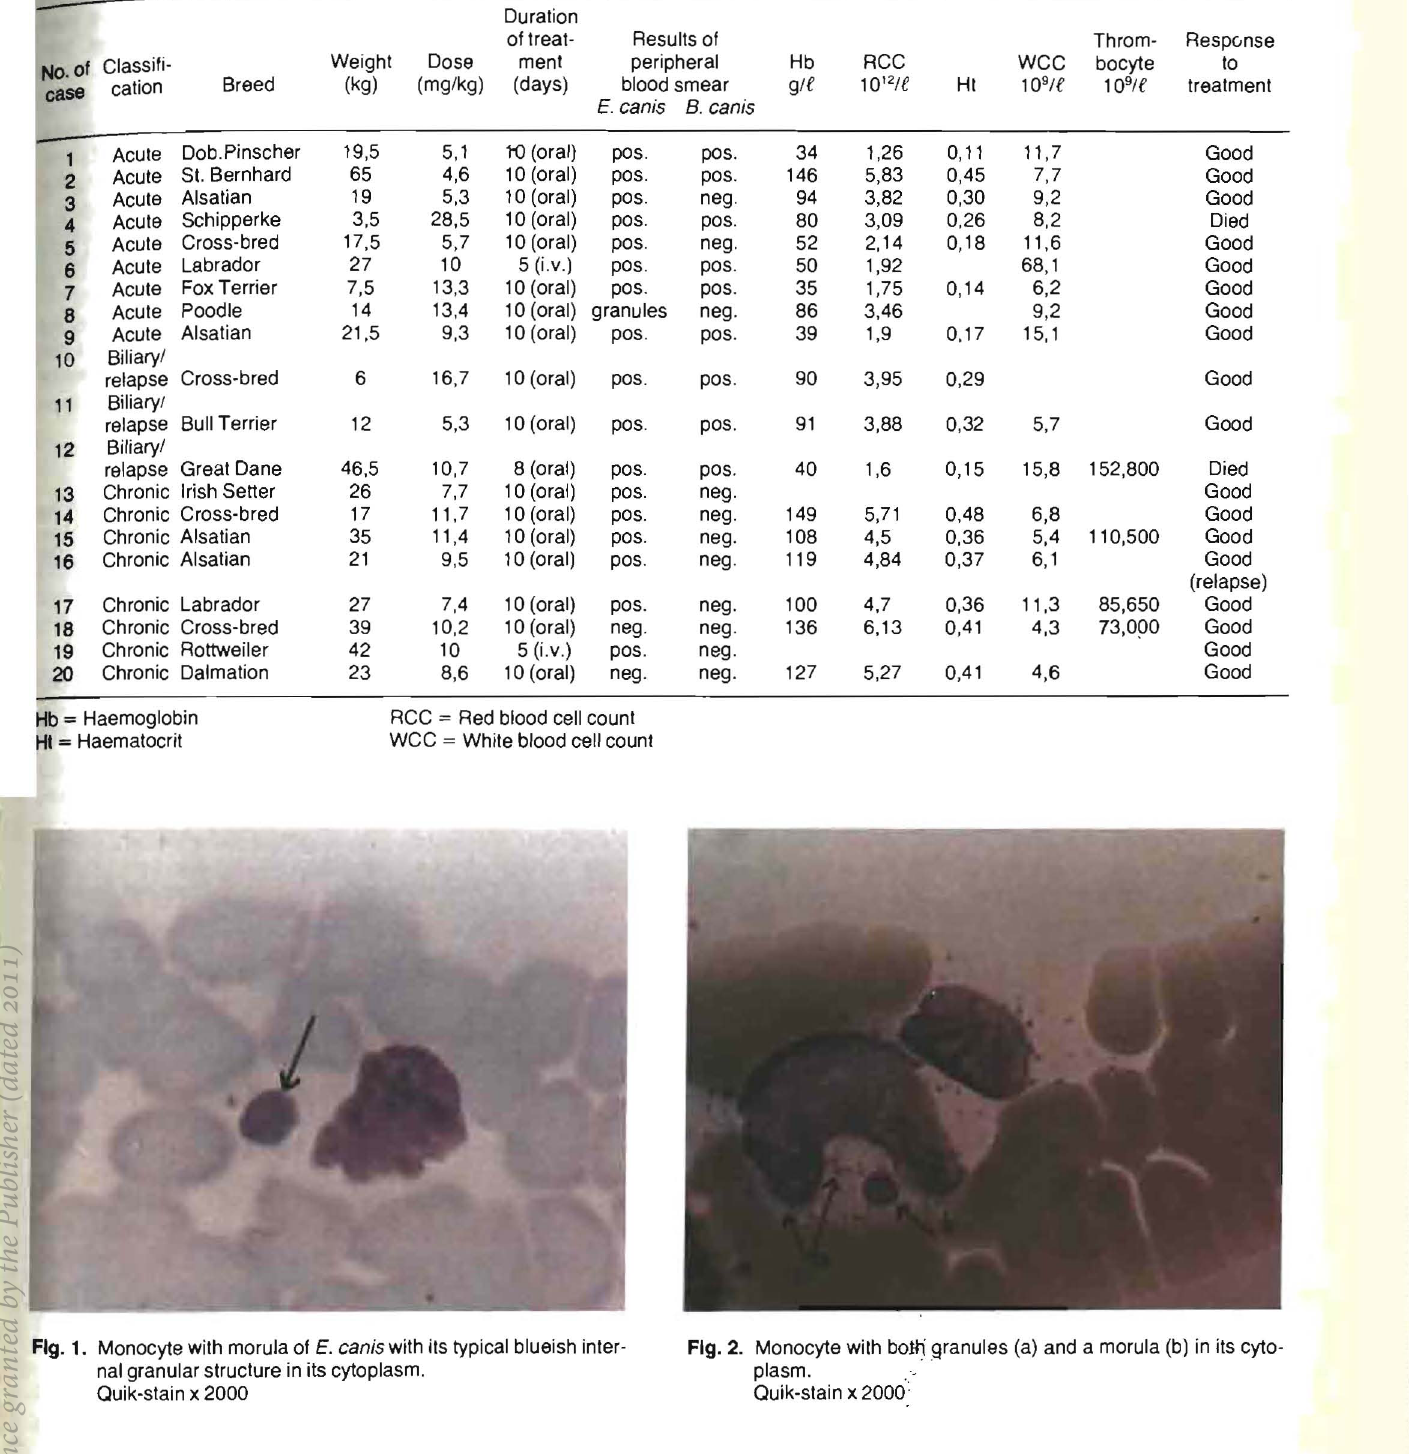
Table 1: THE RESULTS OF TREATMENT OF EHRLlCHIOSIS IN DOGS WITH DOXYCYCLINE Duration 01 treat- Results 01 Throm-